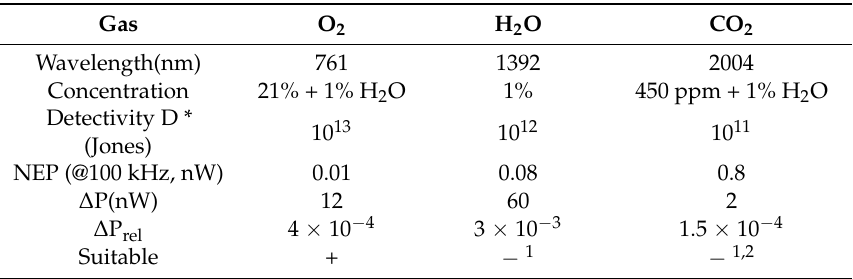
Table 1. Selection of background gases and detection